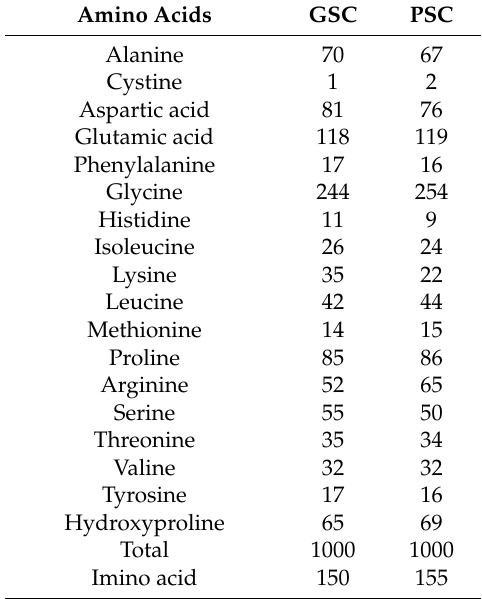
Table 1. Amino acid composition of guanidine hydrochloride soluble collagen (GSC) and pepsin soluble collagen (PSC) from Coelomactra antiquata (results are expressed as residues/1000 residues). Amino Acids GSC